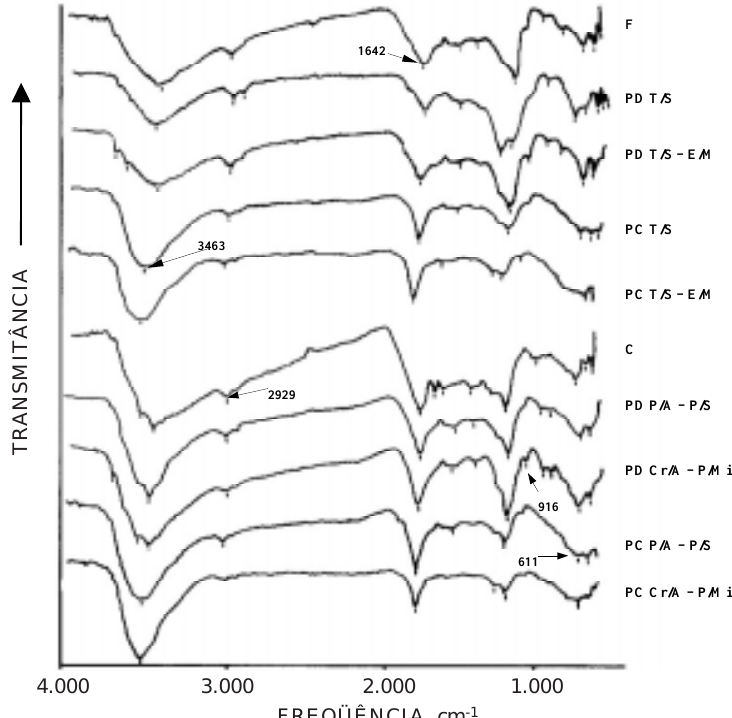
Figura 2. Espectros de infravermelho da fração leve intra-agregado. F: Latossolo sob floresta em Passo Fundo; PD: plantio direto; T: trigo, S: soja; E: ervilhaca; M: milho; PC: preparo convencional;